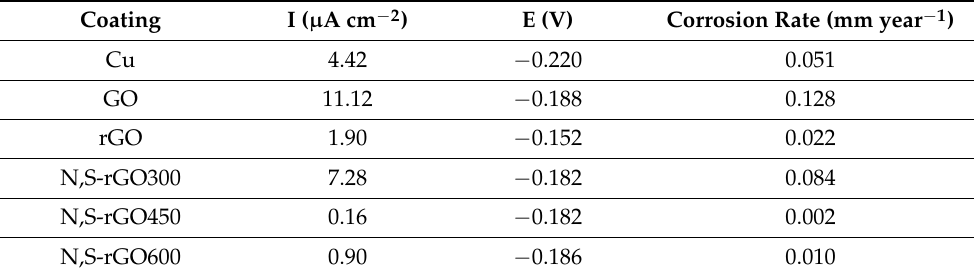
Table 4. Corrosion parameters for bare copper and graphene